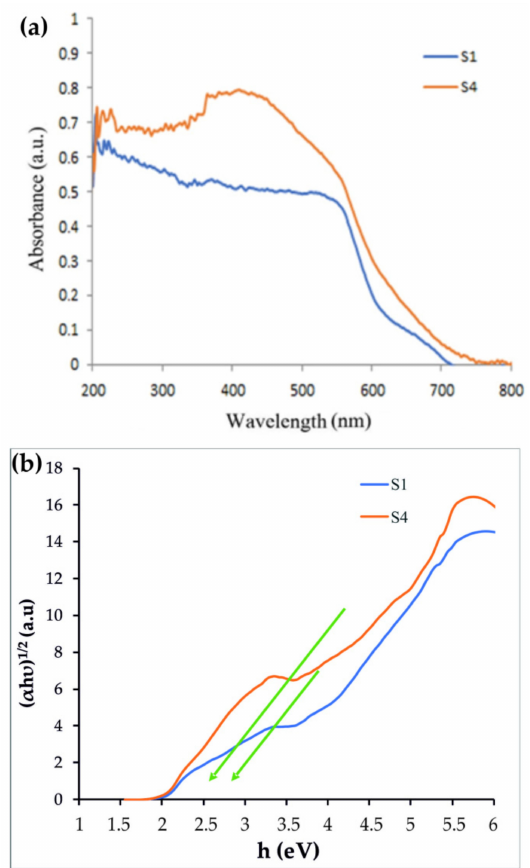
Figure 3. The ( a ) UV-vis absorbance spectra and ( b ) Tauc’s plots for the Fe 3 O 4 / CdWO 4 (S1) and Fe 3 O 4 / CdWO 4 / PrVO 4 (S4) samples.